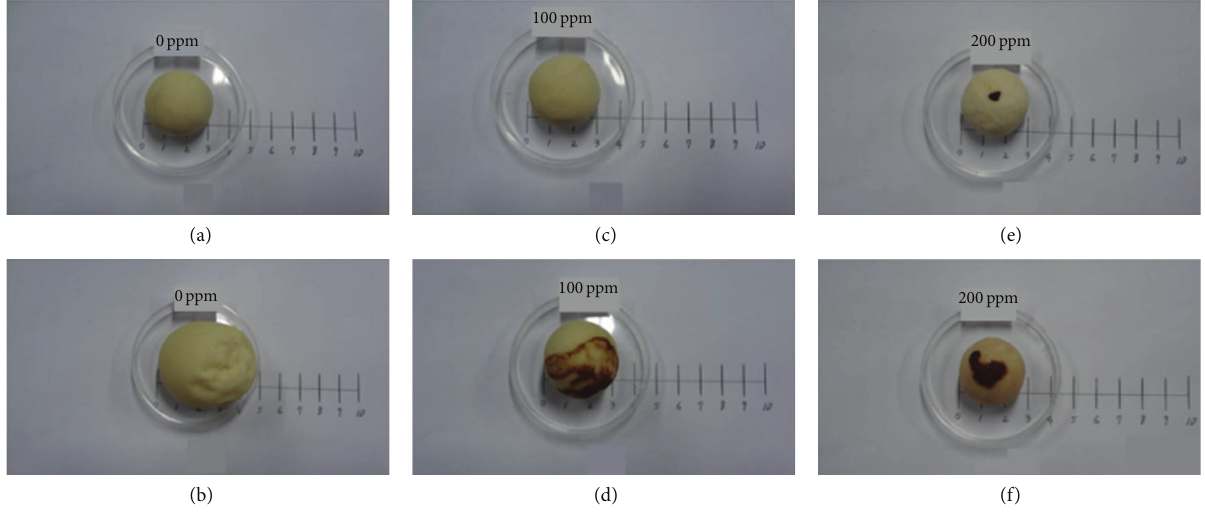
Figure 9: Experiment on antibioactivity of AgNO 3 for yeast.